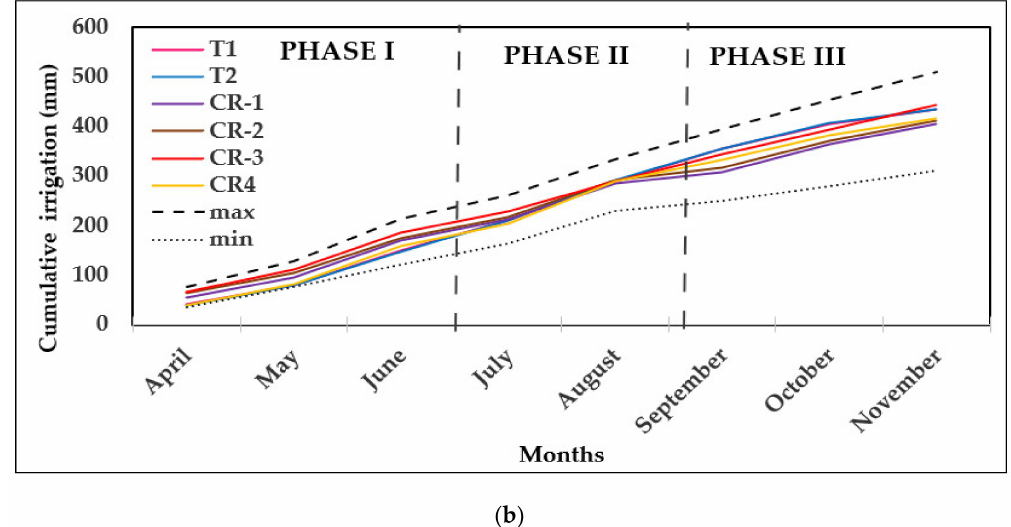
Figure 5. Cumulative irrigation in the di ff erent zones ( a ) 2016 and ( b ) 2017. max and min correspond respectively to the maximum and minimum limits set in the seasonal plan.